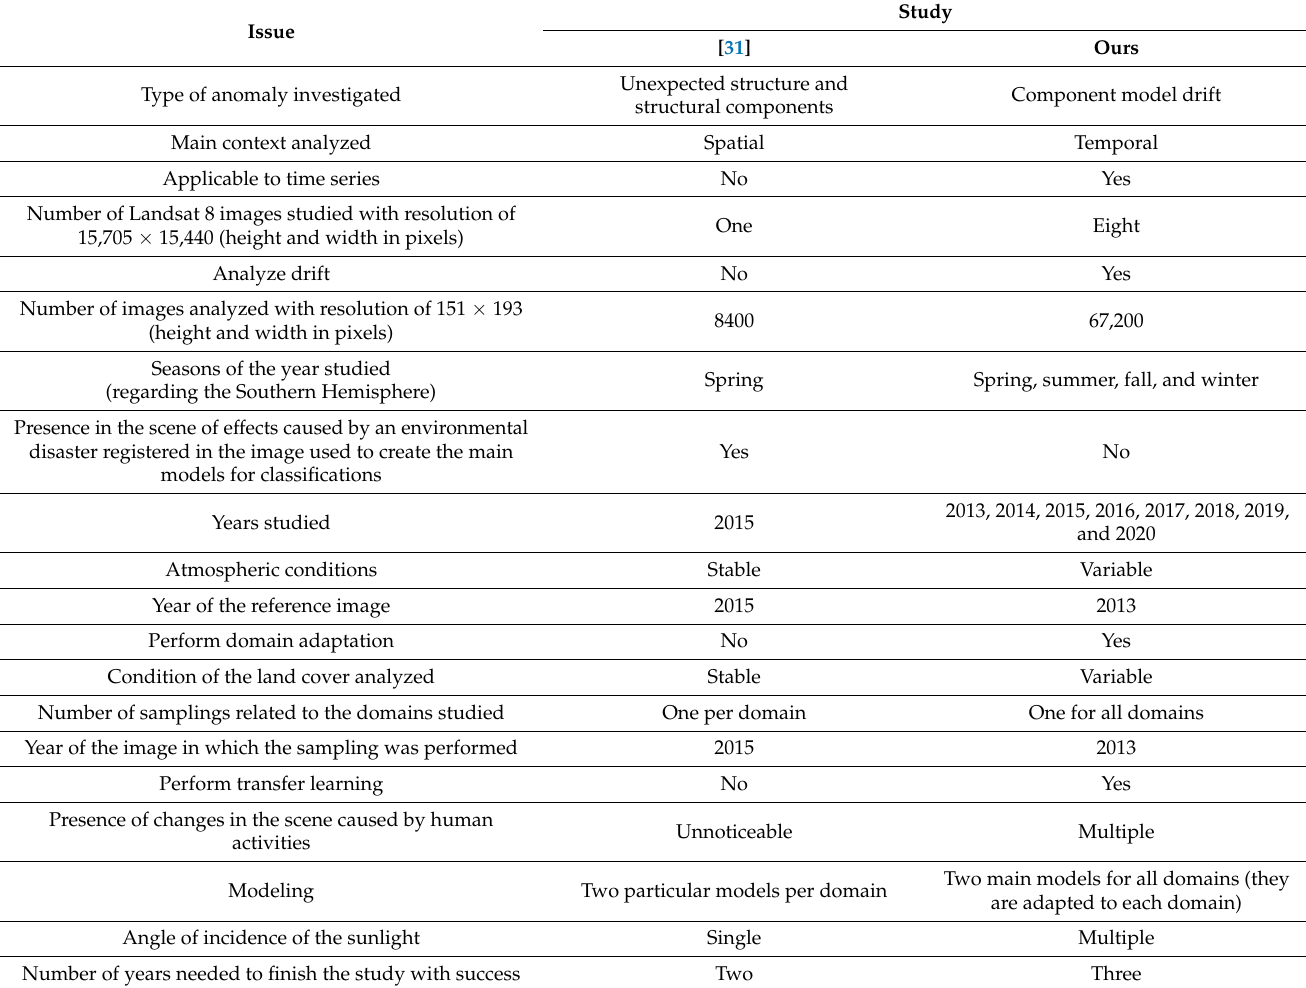
Table 1. Examples of some important differences between our study and the one presented by Dias et al. In [31], taking into consideration only the area commonly studied by both